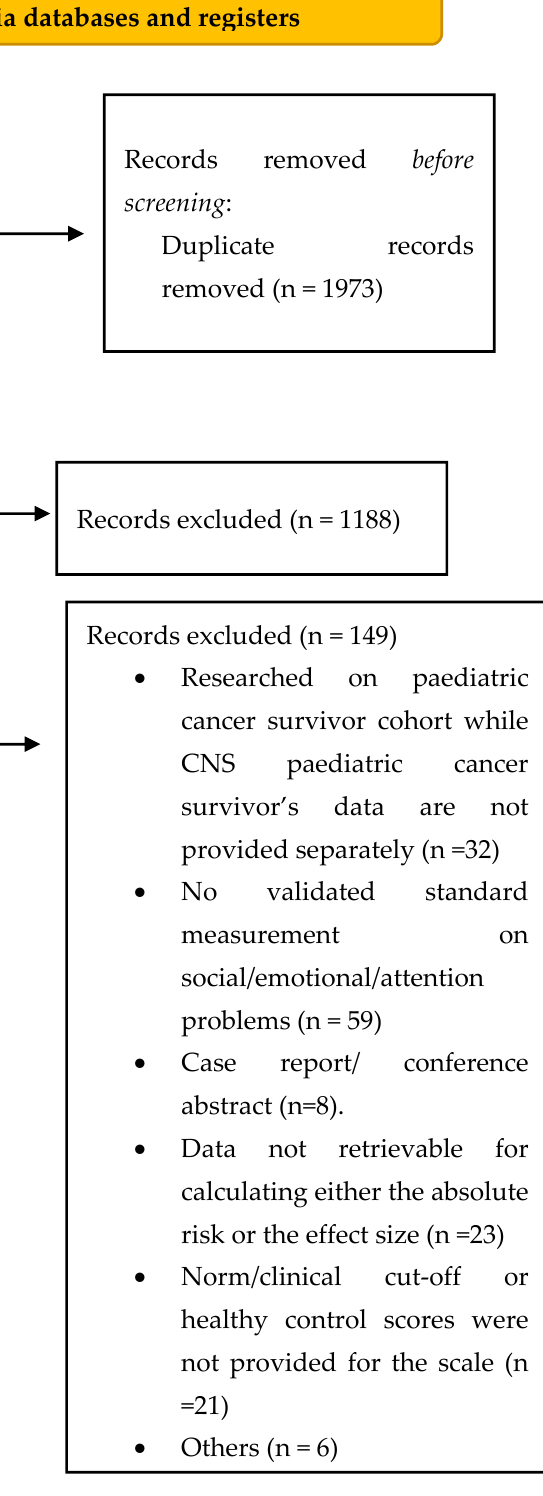
Figure 1. Inclusion of studies.